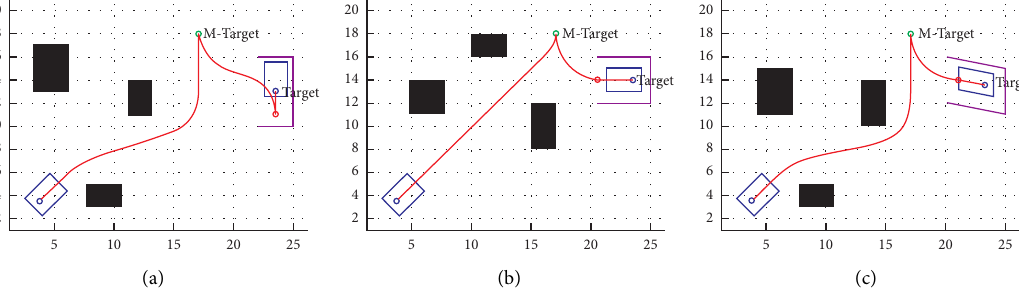
Figure 21: Three kinds of parking space path planning simulation diagram. (a) Plan path in parallel parking space. (b) Plan path in vertical parking. (c) Plan path in tilted